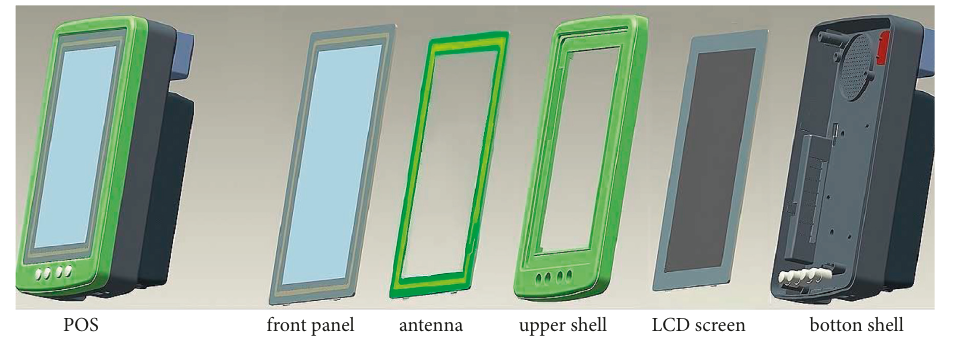
Figure 10: POS assembly